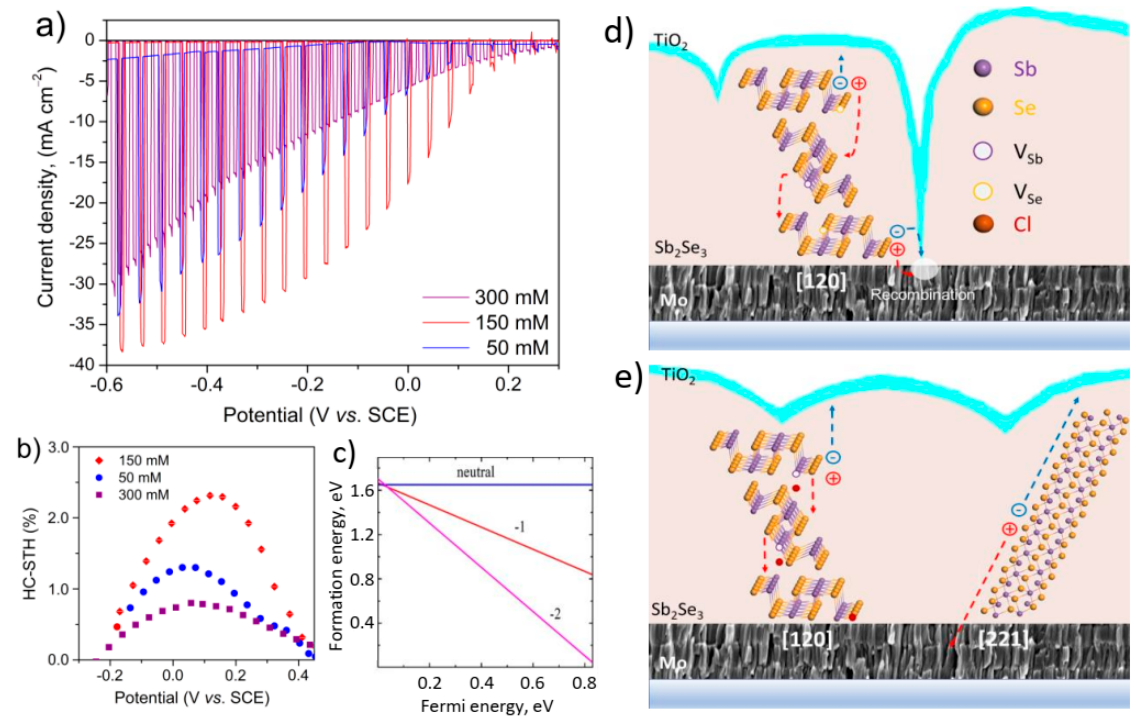
Figure 5. ( a ) J-V curves for Mo/TR-Sb 2 Se3/TiO 2 /IrOx electrodes recorded in 1M H 2 SO 4 electrolytes using a sweep rate potential of 20 mV s –1 from positive to negative potential. ( b ) HC-STH efficiencies. ( c ) Formation energy for the V Sb -Cl Se complex forming acceptor states within the bandgap. ( d , e ) Recombination of charge carries, possible ways for passivation of GBs and charge separation along the